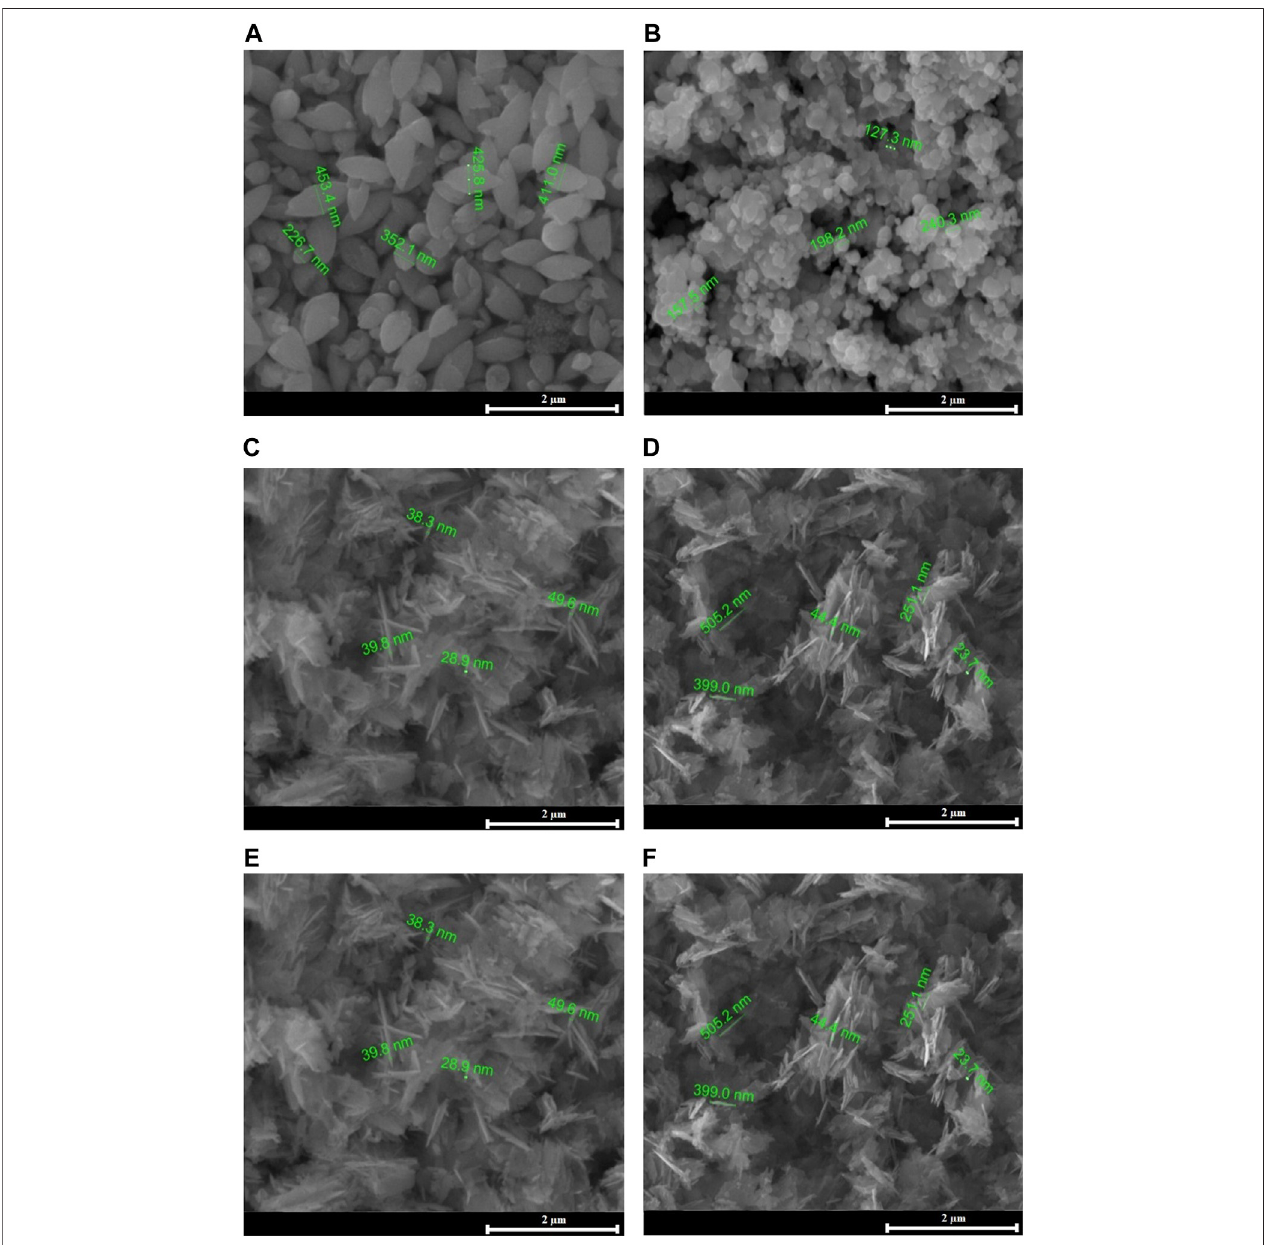
FIGURE 1 | SEM images of the ZnO samples: (A) — ZP 20, (B) — ZP 15, (C) — ZP 19, (D) — ZP 22, (E) — ZP 26, (F) — ZP 23.